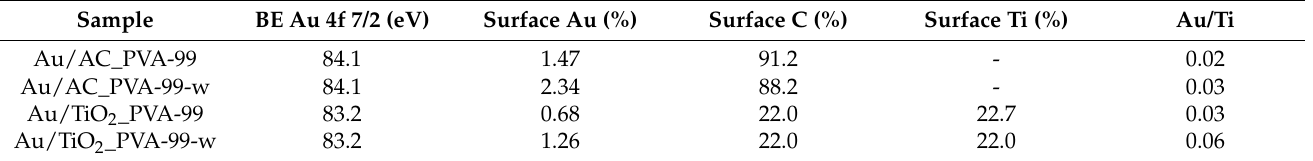
Figure 13. IR spectra of TiO 2 , Au/TiO 2 , and Au/TiO 2 catalysts after the treatment with hot water. Table 3. XPS data for the catalysts treated and untreated supported on activated carbon and titania.